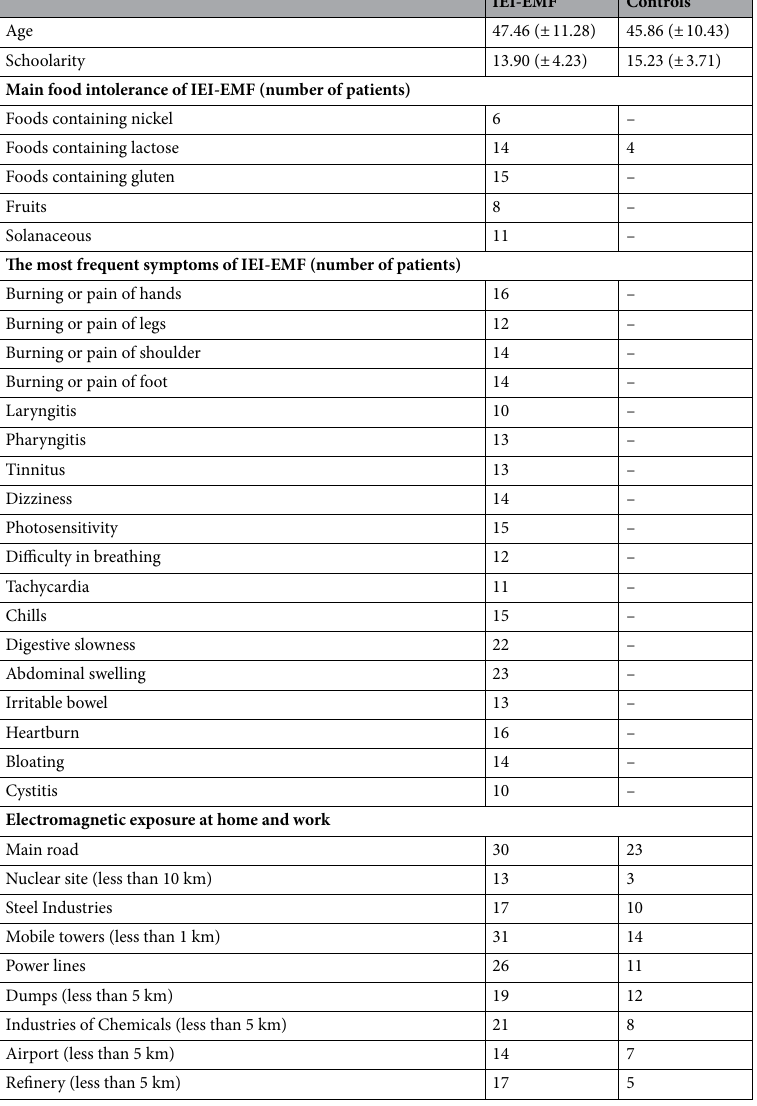
Table 3. Demographic characteristics of the population (means and standard